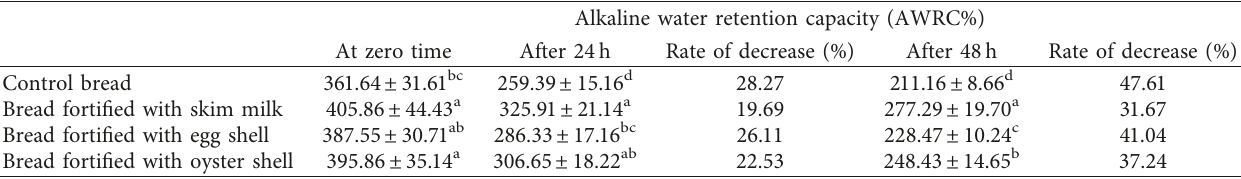
Table 7: Alkaline water retention capacity of the control bread and breads fortified with skim milk and egg shell and oyster shell powders.